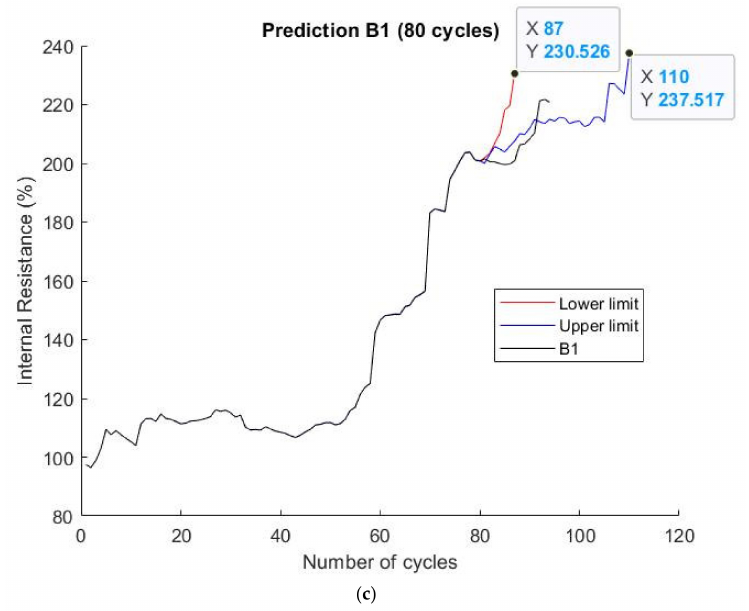
Figure 27. Results of prediction of battery 1: ( a ) 20 cycles; ( b ) 50 cycles; ( c ) 80 cycles.